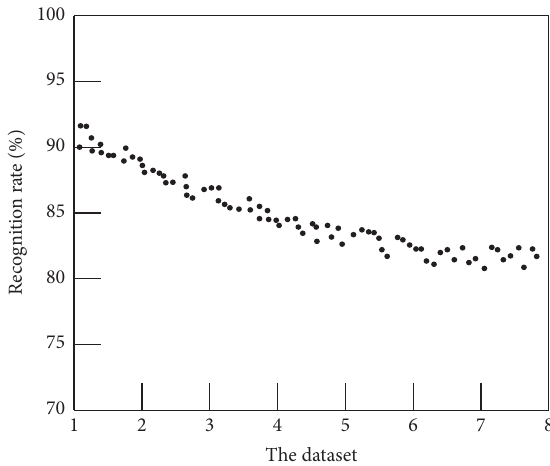
Figure 3: Changes in the recognition rate of Method 1.